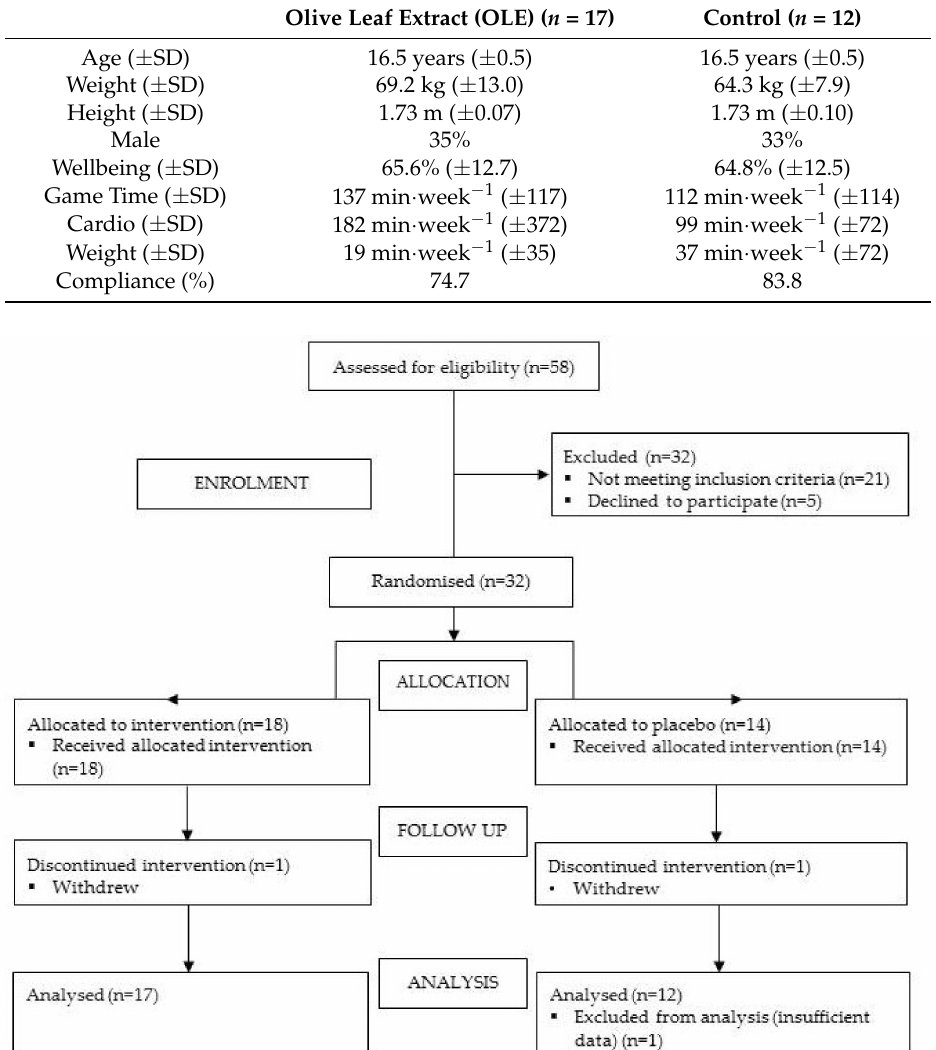
Figure 1. CONSORT